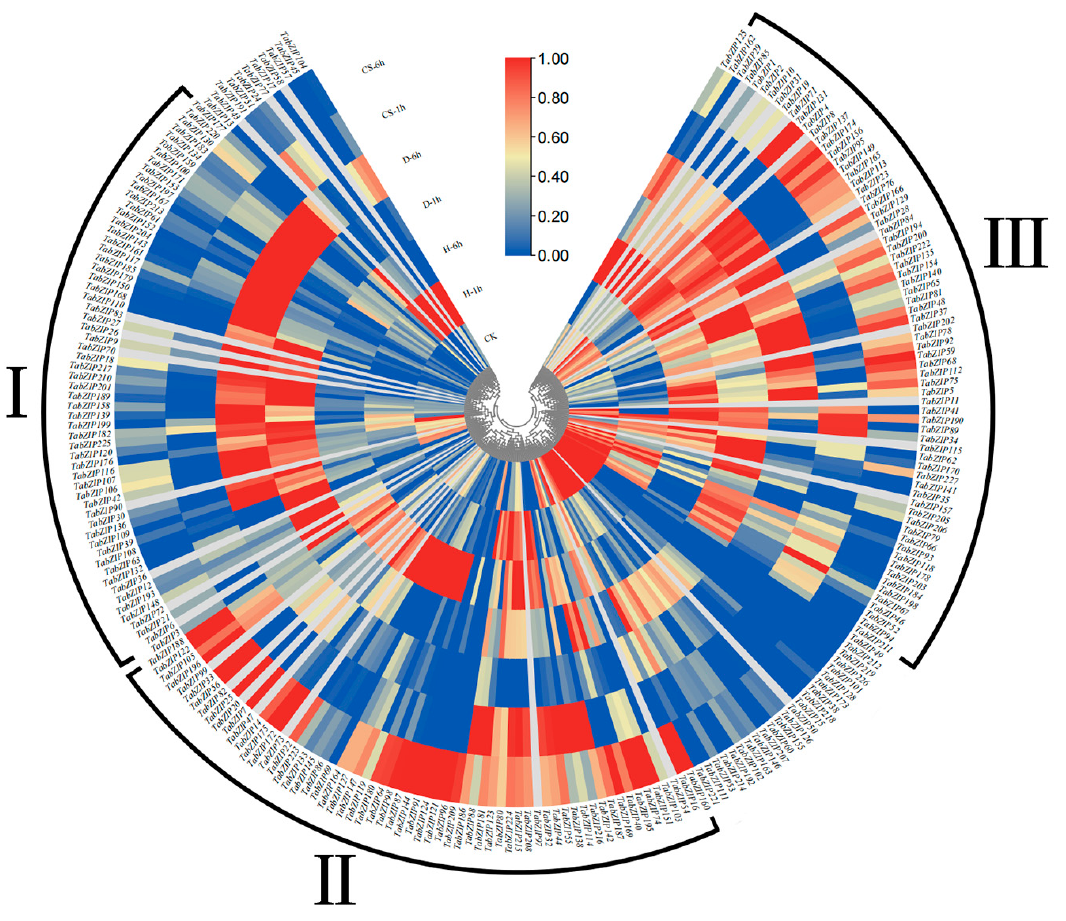
Figure 6. Transcriptional profiles of TabZIP gene family members in wheat under heat stress (H-1/H-6), drought stress (D-1/D-6), and combined stress (CS-1/CS-6). Grids with colors indicate low/down expression (blue), high/up expression(red), and non-expression/no change (yellow). According to the similarity of expression characteristics, some genes were classified into Group I, Group II and Group III respectively.